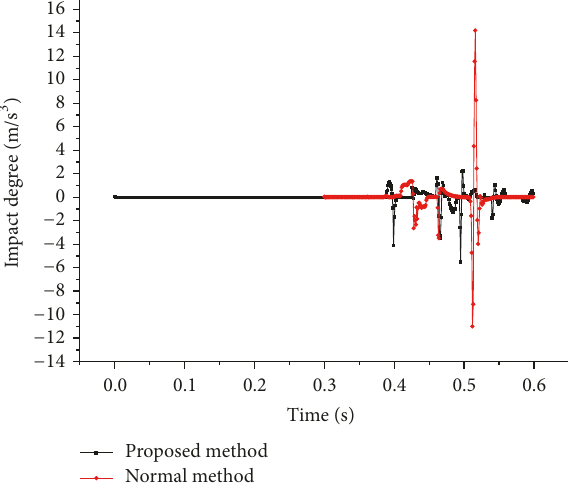
Figure 18: The impact degree curves of the proposed method and normal method with an optimal displacement curve.